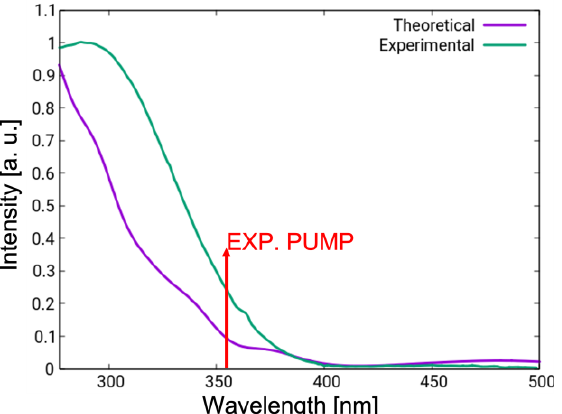
Figure 4. Linear absorption spectrum in chloroform simulated at the TD-DFT/CAM-B3LYP level on the basis of vertical excitation energies of 200 geometries obtained by means of Wigner sampling (violet) compared to the experimental spectrum (green). Red arrow indicates the central wavelength of the experimental pump pulse.